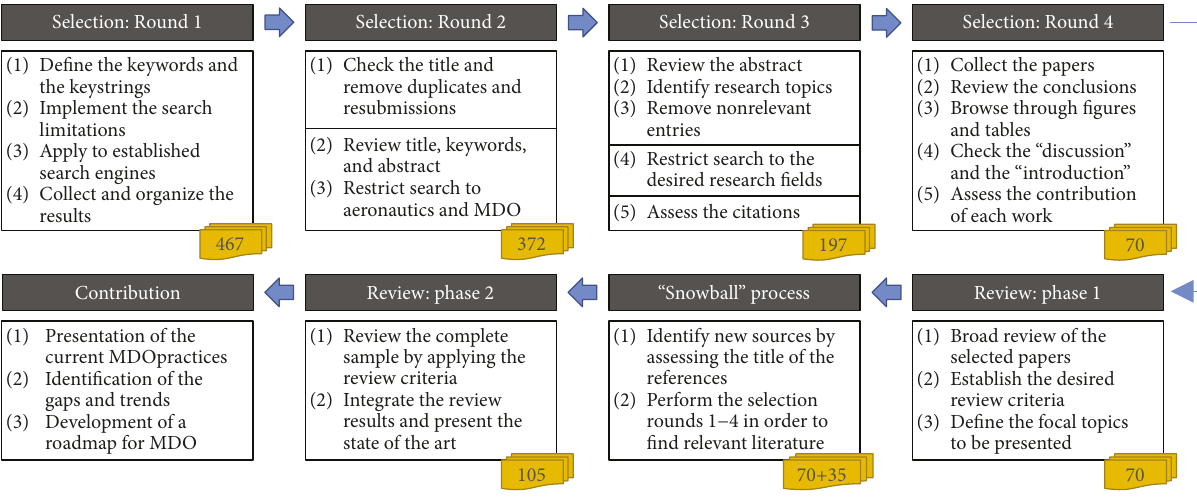
Figure 1: The review methodology. Table 1: The keywords, keystrings, and search criteria used in the review process. Search fi elds